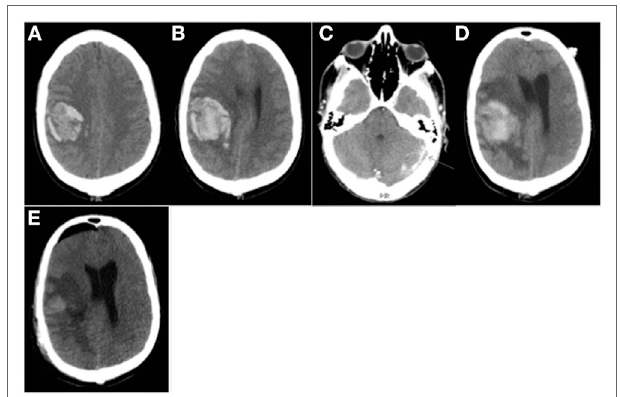
FIgURe 2 | Patient 1. CT head (a,B,D) and CT venography (C) prior to surgery: (a) Day 6: large right frontal cerebral hematoma (40 mL), moderate mass effect with 4 mm of maximal brain midline shift. (B) Day 7: hematoma volume increase up to 45 mL. (C) Day 13: left lateral venous sinus thrombosis. (D) Day 14, just before surgery: increased mass effect (10 mm brain midline shift) with peripheral edema. CT head after surgery: (e) Day 16: decreased mass effect (6 mm brain midline